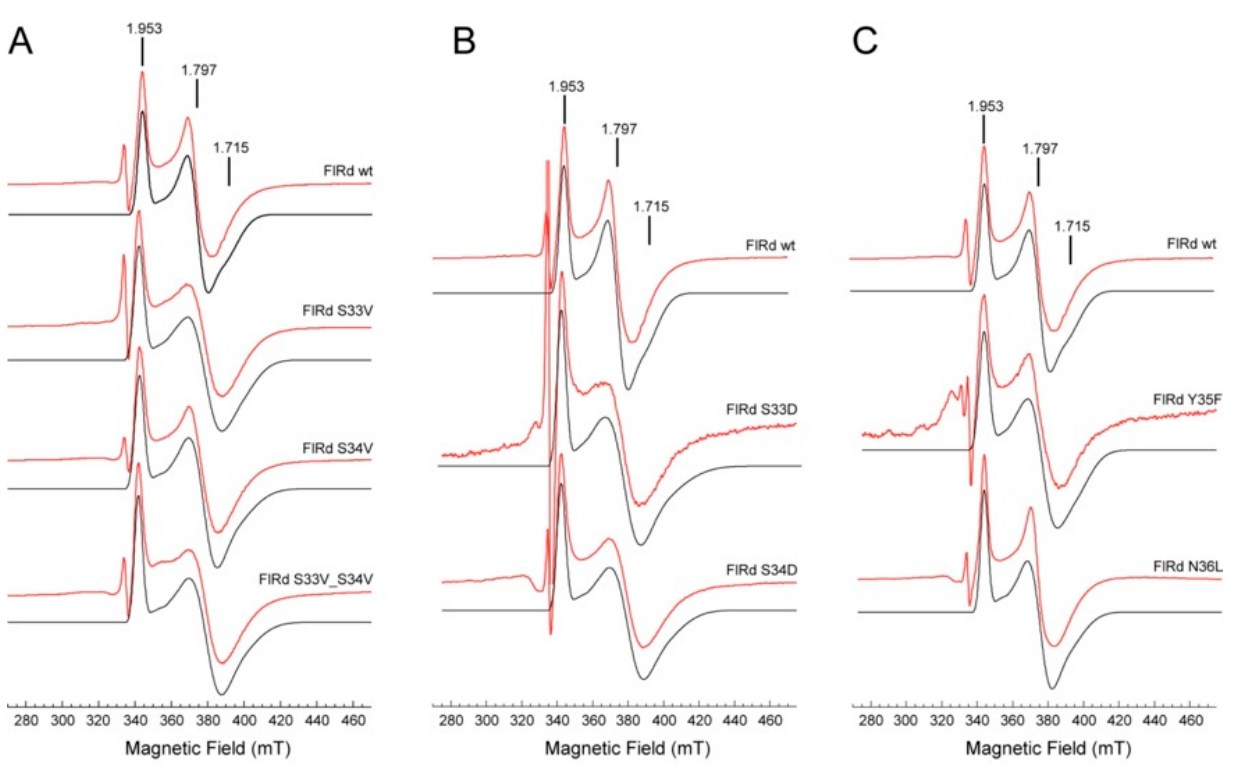
Figure 3. EPR spectra of diiron centers of FDP wt and site-directed mutants. EPR spectra of the E. coli FDP and its mutants (red lines) incubated with substoichiometric amounts of menadiol recorded at 7 K, with a microwave frequency of 9.39 GHz, a modulation amplitude of 1.0 mT and a microwave power of 2 mW. ( A ) S33V, S34V and S33V_S34V mutants compared with the wt protein. ( B ) S33D and S34D mutants compared with the wt protein. ( C ) Y35F and N36L mutants compared with the wt protein. The black lines below the experimental spectra are the simulated spectra with the g-values presented in Table 1. The protein concentration was 200 µM in 50 mM Tris-HCl, pH 7.5, 18% glycerol.